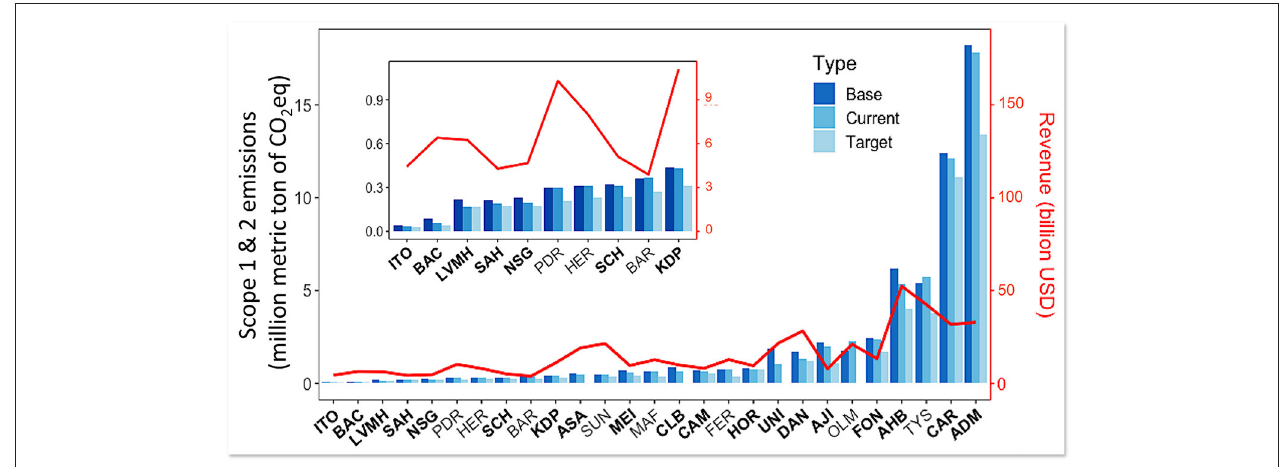
FIGURE 5 | Distribution of base year emissions, current (2020 report) emissions, and target year emissions for 27 companies with absolute goals and emissions data for scopes 1 and 2. Red line and y-axis correspond to 2020 revenue for each company in billions of USD. Smaller graph within is zoomed in on the smallest 10 companies. Acronyms left to right with base and target years: Ito En (ITO: 2018–2030), Bacardi (BAC: 2015–2025), LVMH (2013:2020), Sapporo Holdings (SAH: 2013–2030), Nisshin Seifun Group (NSG: 2013–2030), Pernod Ricard (PDR: 2018–2025), The Hershey Company (HER: 2015–2025), Schreiber Foods